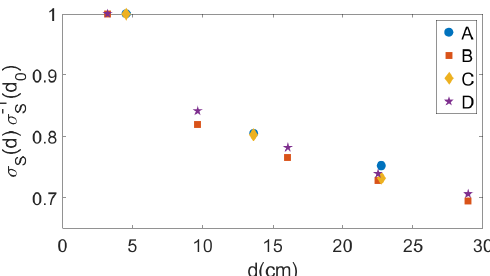
Figure 3. The positions of the virtual temperature sensors in the LES at z = 0 . 5m.